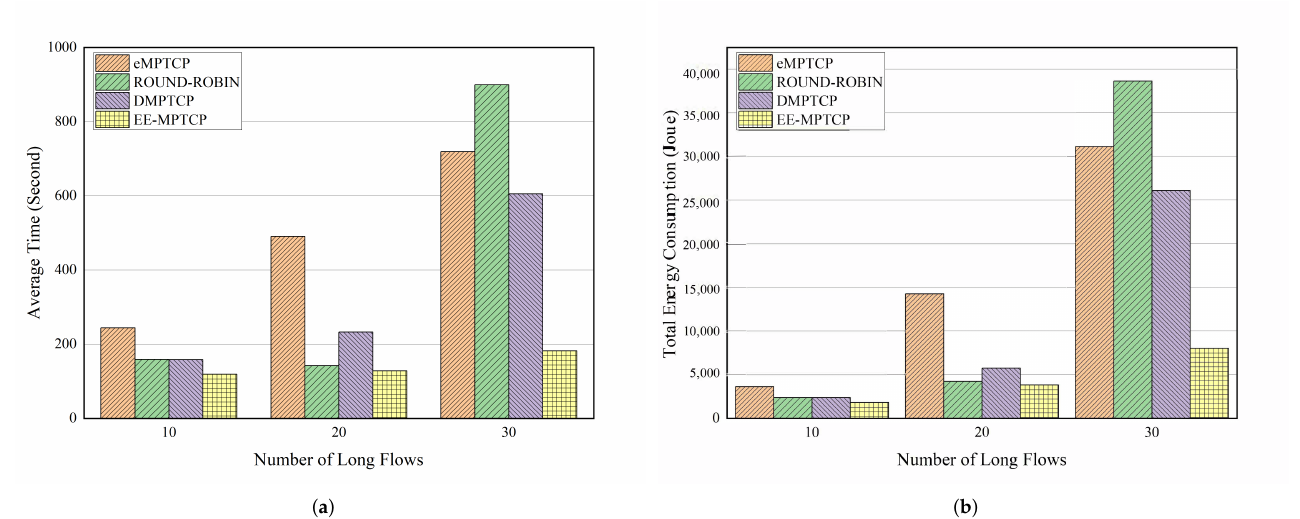
Figure 7. The evaluation results of the four algorithms, namely eMPTCP [14], the default ROUND- ROBIN, DMPTCP [27] and the proposed EE-MPTCP with varying number of long flows with the size of 10 MB that transmitted concurrently in the network environment that consists of one LTE path and one WLAN path. ( a ) The average completion time of all flows. ( b ) The total energy cost during the whole